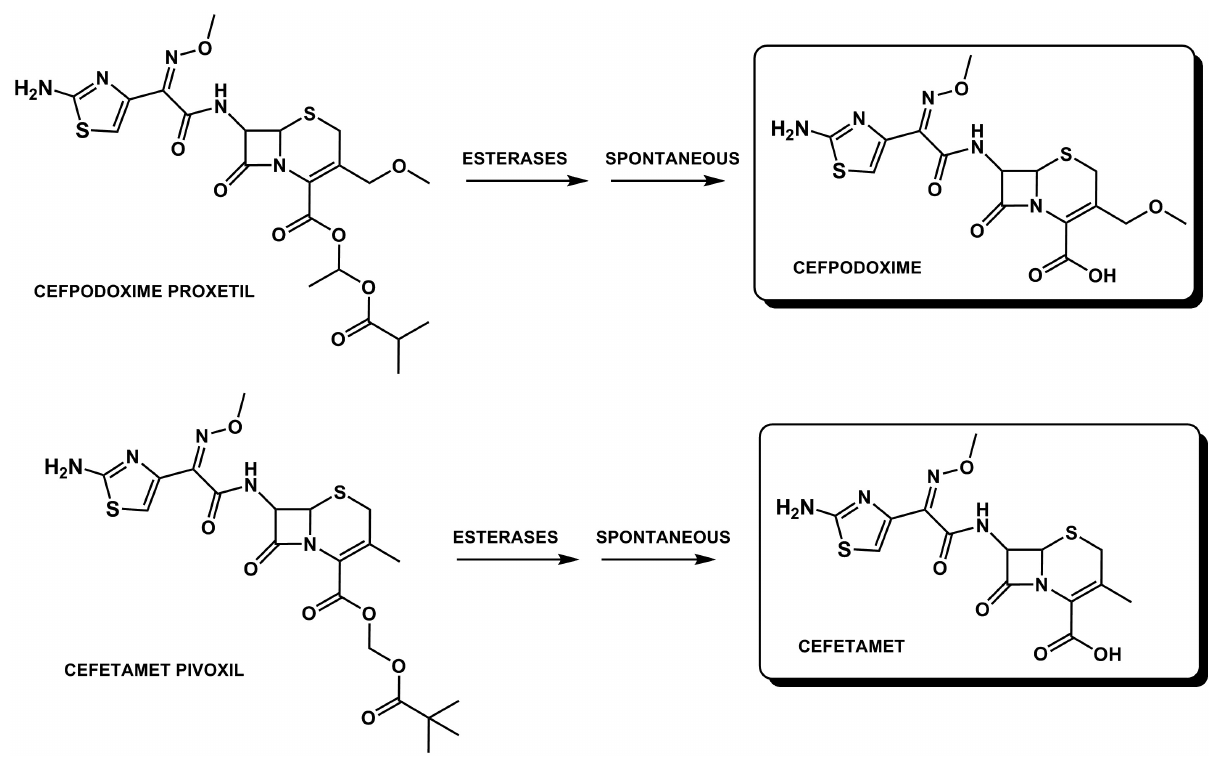
FIGURE 22 - Cefpodoxime proxetil and cefetamet pivoxil structures being bioactivated into cefpodoxime and cefetamet, respectively.